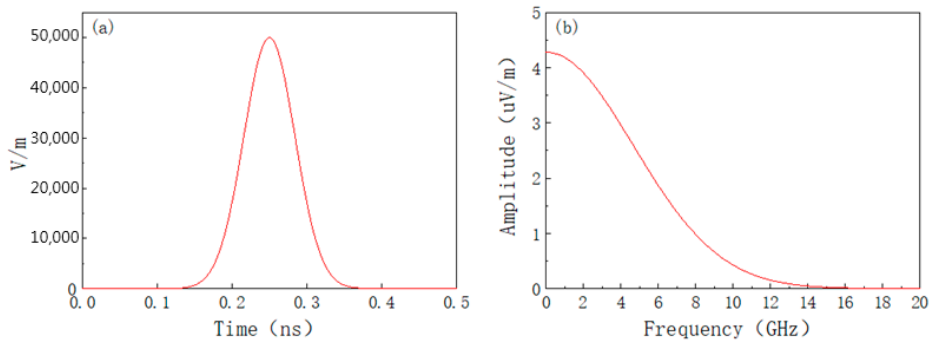
Figure 10. UWB waveform: ( a ) time domain; ( b ) frequency domain.